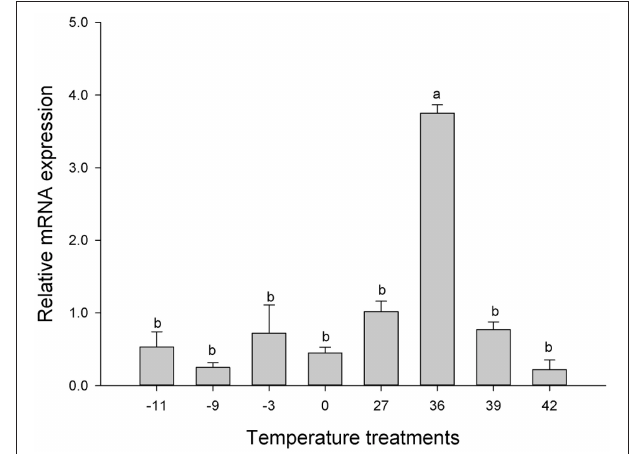
FIGURE 4 | Relative mRNA expression levels of the Cs Drip1 gene in different tissues (organs) of the Chilo suppressalis . HG, hindgut; MG, midgut; FG, foregut; HC, haemocytes; MT, Malpighian tubules; EP, epidermis; FB, fat body and HE, Heads. Values are denoted as the mean ± SE. Significant differences are indicated as P < 0.05.